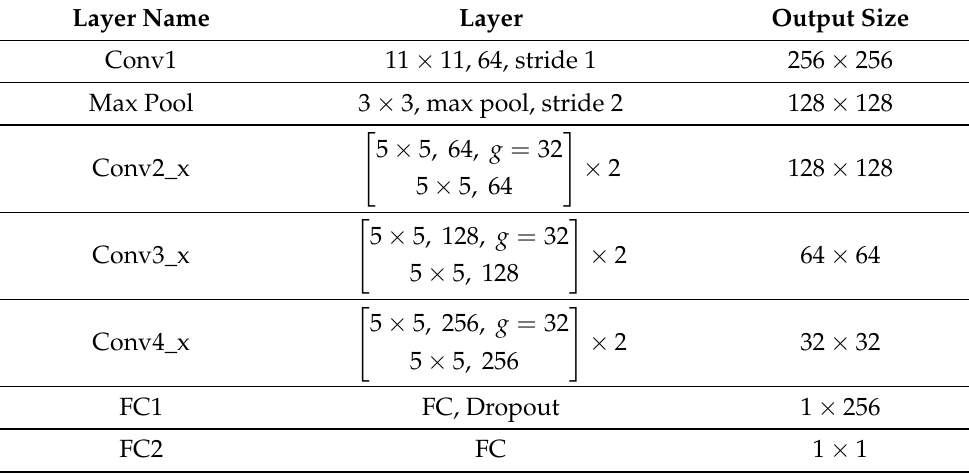
Table 2. The illustration of the deep residual regression network based on group